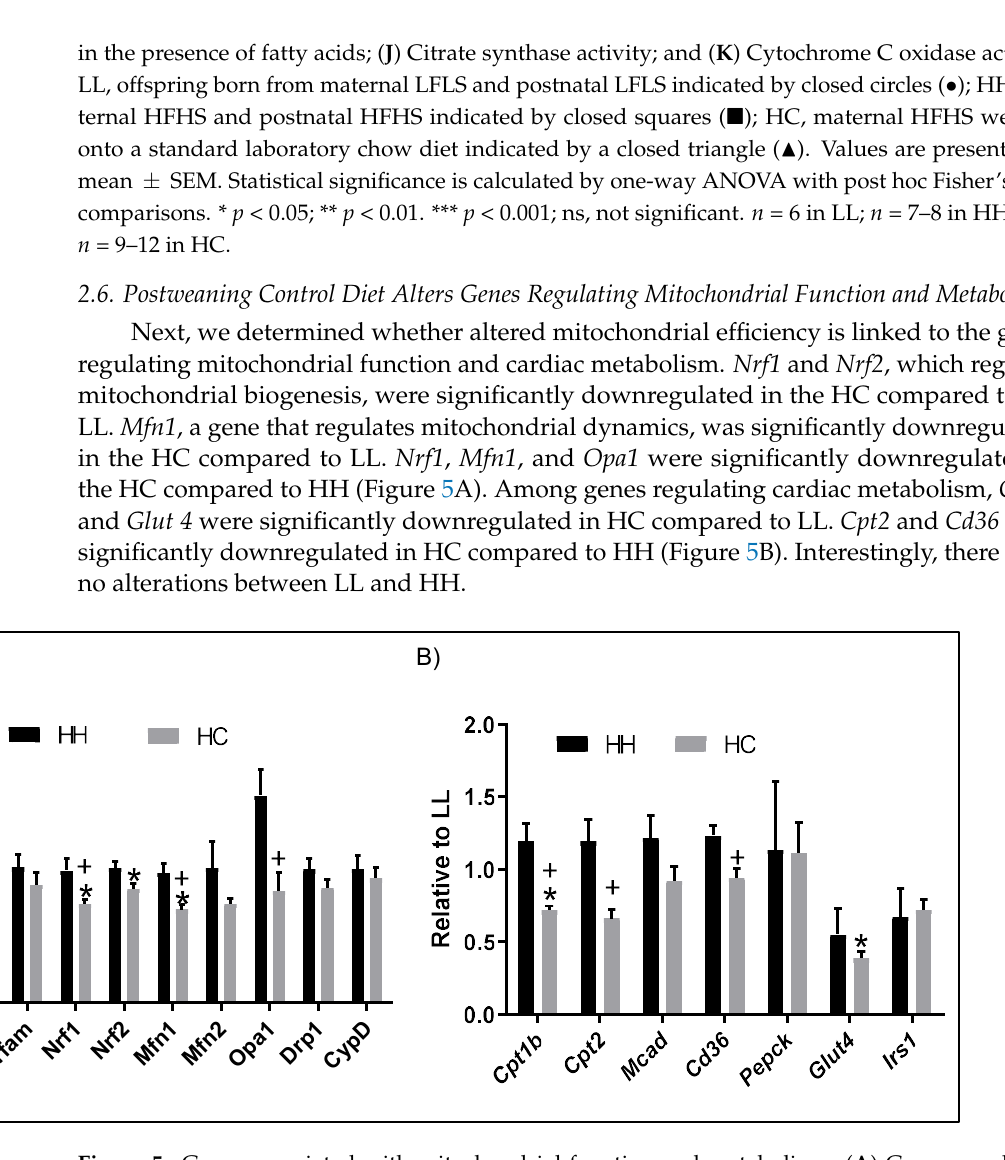
Figure 5. Genes associated with mitochondrial function and metabolism. ( A ) Genes regulating mitochondrial biogenesis and dynamics; and ( B ) Fatty acids and glucose metabolism. Ppargc1α , peroxisome proliferator-activated receptor gamma coactivator 1-alpha; Tfam , mitochondrial transcription factor A; Nrf , nuclear respiratory factor; Drp1 , dynamic-related protein 1; Mfn , dynamic-related GTPase termed mitofusin; Opa1 , optic atrophy protein 1; CypD , peptidylprolyl isomerase D; Cpt , creatine palmitoyltransferase; Cd36 , the surface receptor cluster of differentiation 36; Glut4 , glucose transporter type 4; Mcad , acyl-CoA dehydrogenase medium-chain; Pepck , phosphoenolpyruvate carboxykinase, mitochondrial; Irs1 , insulin receptor substrate 1; LL, offspring born from maternal LFLS and postnatal LFLS; HH, maternal HFHS and postnatal HFHS; HC, maternal HFHS weaned onto a standard laboratory chow diet. Values are presented as mean ± SEM as fold change relative to the LL group. Statistical significance is calculated by one-way ANOVA with post hoc Fisher’s LSD comparisons. * p < 0.05, versus LL; + p < 0.05, versus HH. n = 4–8 samples/group.